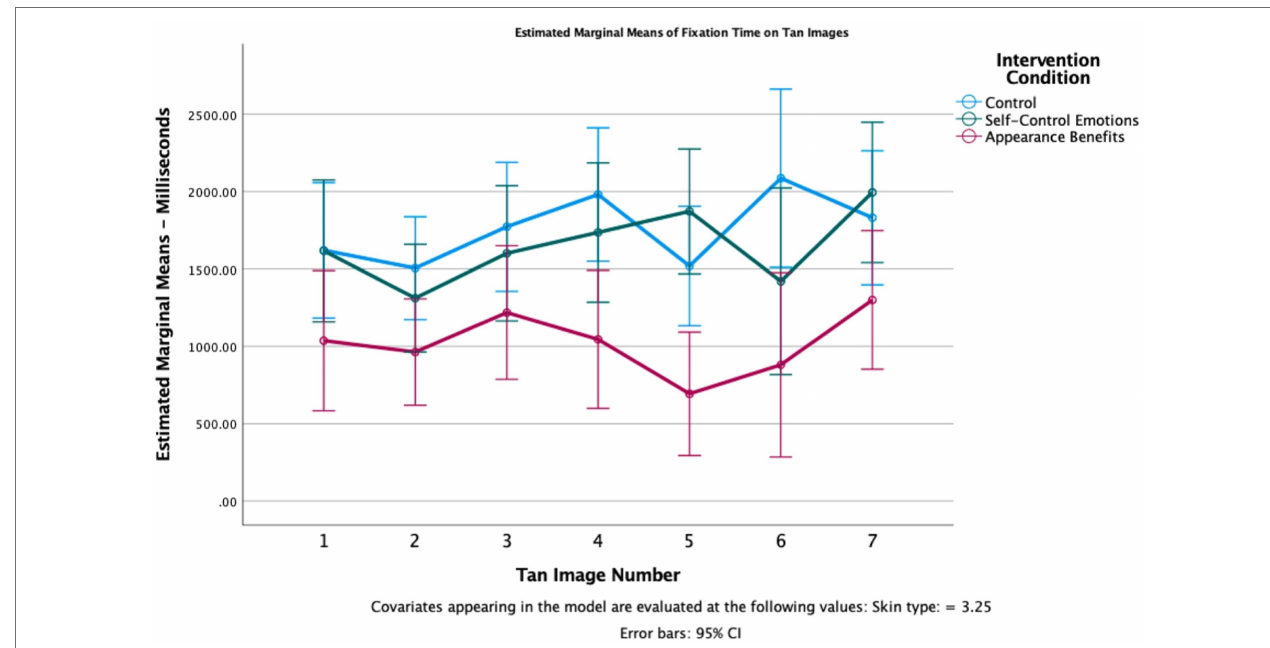
FIGURE 2 | Fixation time on the tan images by condition for each pair of Instagram screenshots.